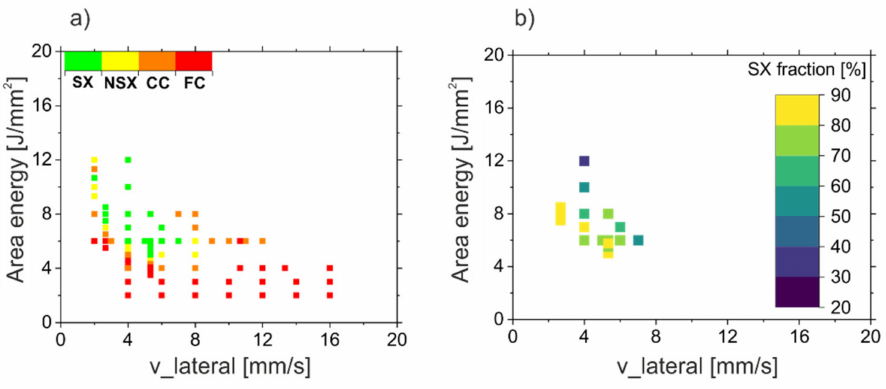
Figure 7. SX process window. ( a ): Microstructure map in dependency of area energy and v_lateral for the investigated hatch distances between 100 to 200 µ m, ( b ): SX-fraction of the samples of ( a ) determined according to Figure